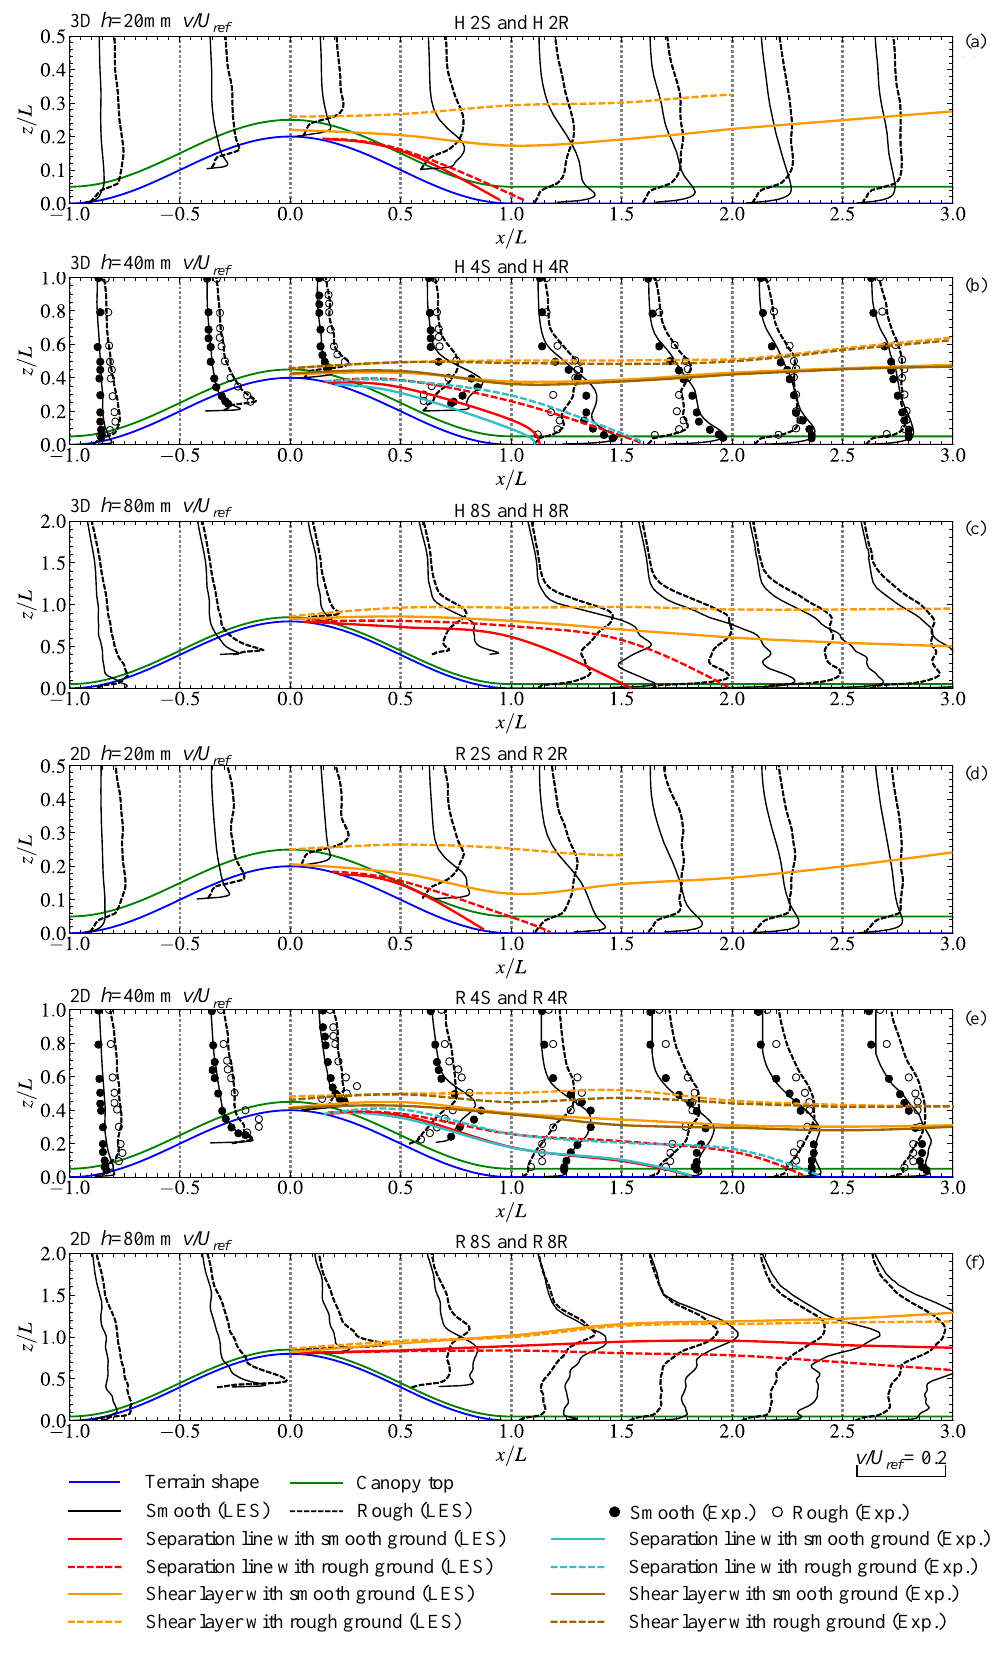
Figure 7. Vertical profiles of v , ( a ) 3D hills with h = 20 mm, ( b ) 3D hills with h = 40 mm, ( c ) 3D hills with h = 80 mm, ( d ) 2D hills with h = 20 mm, ( e ) 2D hills with h = 40 mm, and ( f ) 2D hills with h = 80 mm.